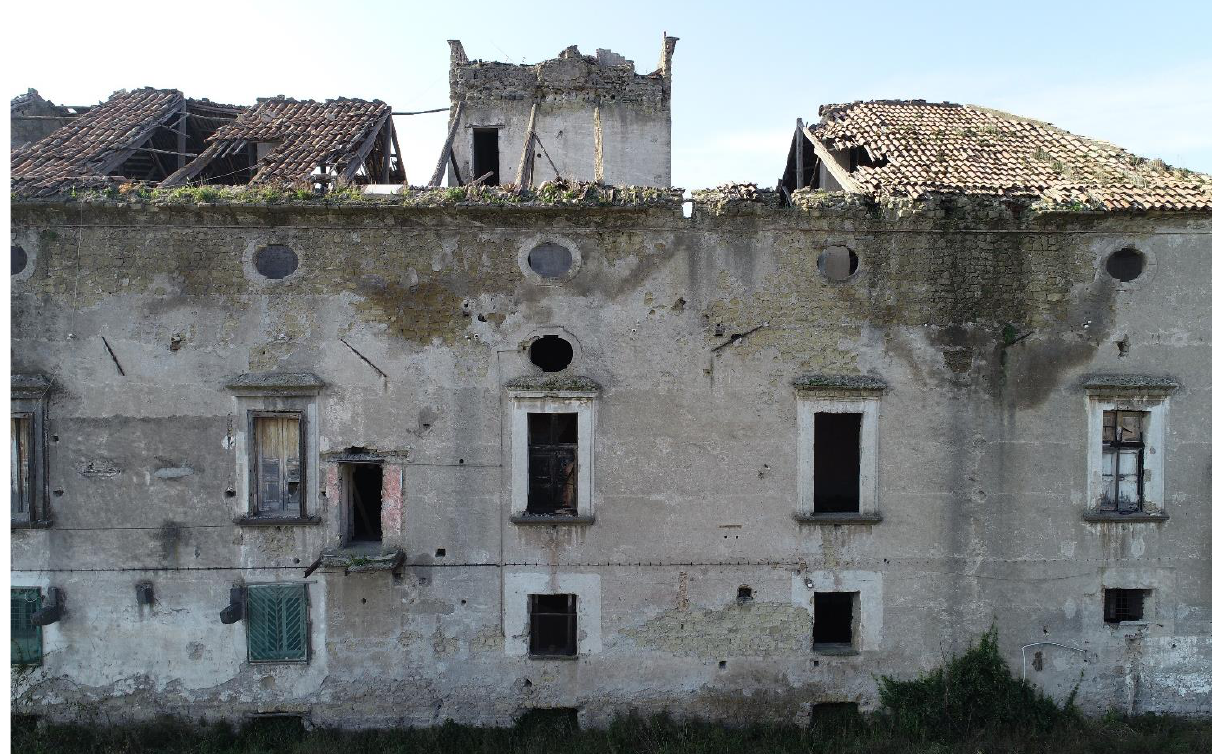
Figure 7. The facade facing Vesuvius (M. Facchini,